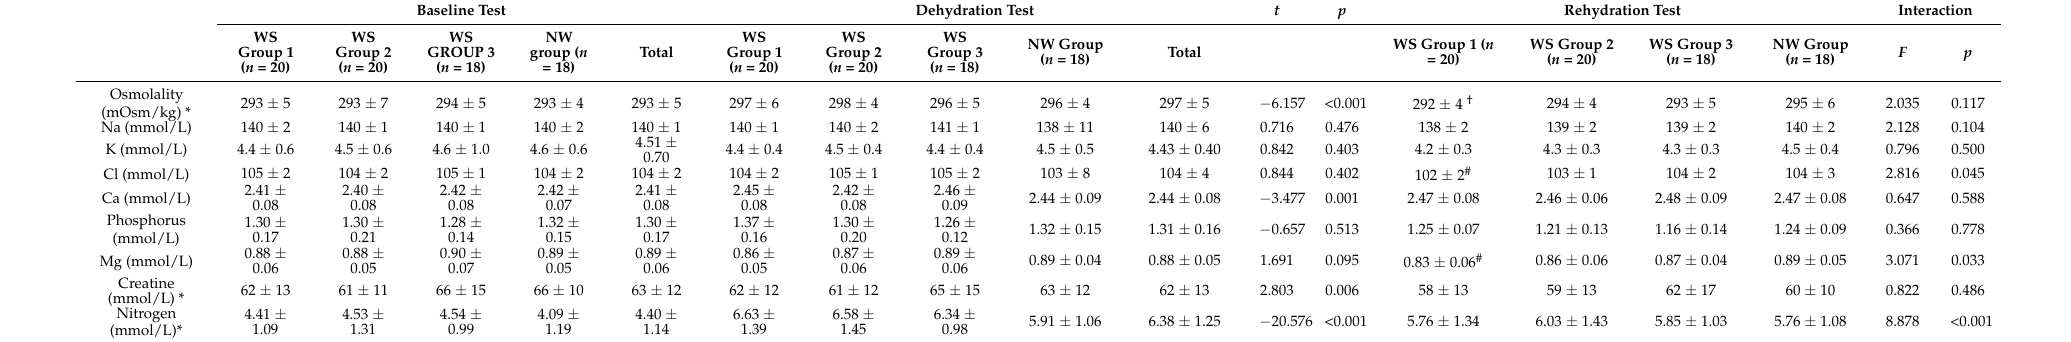
Table 5. The plasma biomarkers of the participants.